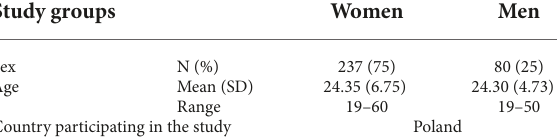
TABLE 1 Baseline characteristics of